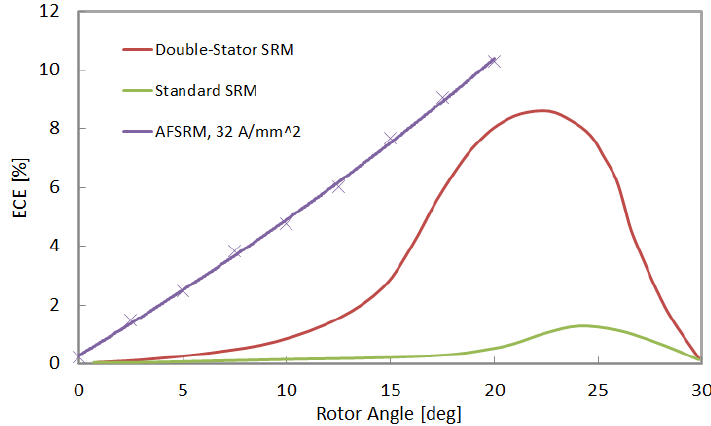
Figure 19. The ECE of th AFSRM compared to that of a double-stator SRM and a standard SRM